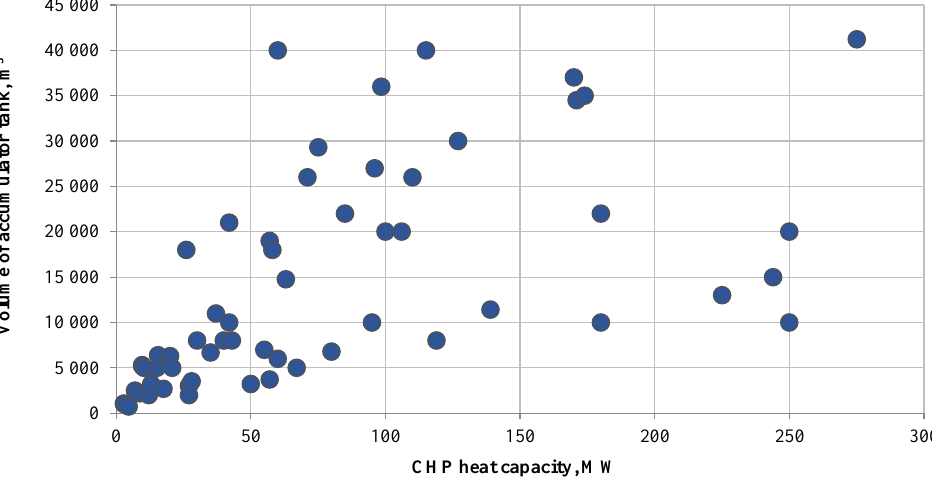
Fig. 1. Accumulator volume based on CHP heat